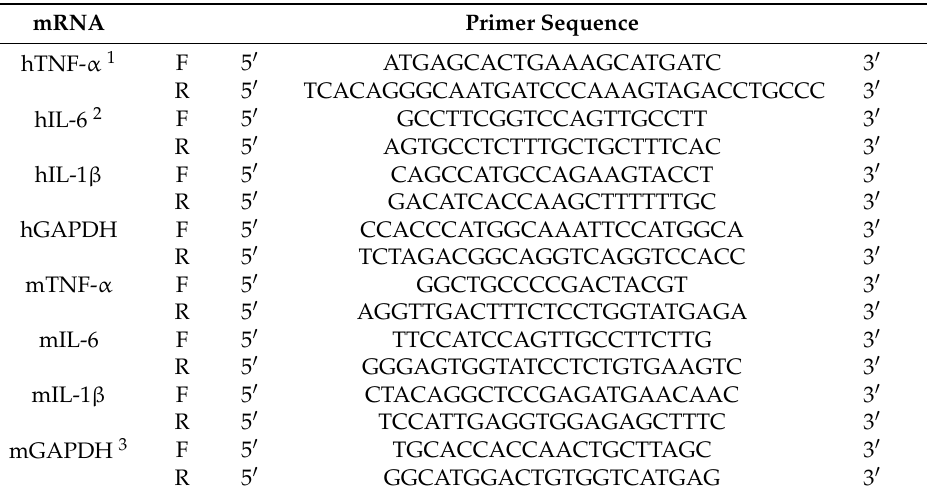
Table 1. Primers sequences used in real-time PCR analysis. F: forward; R: